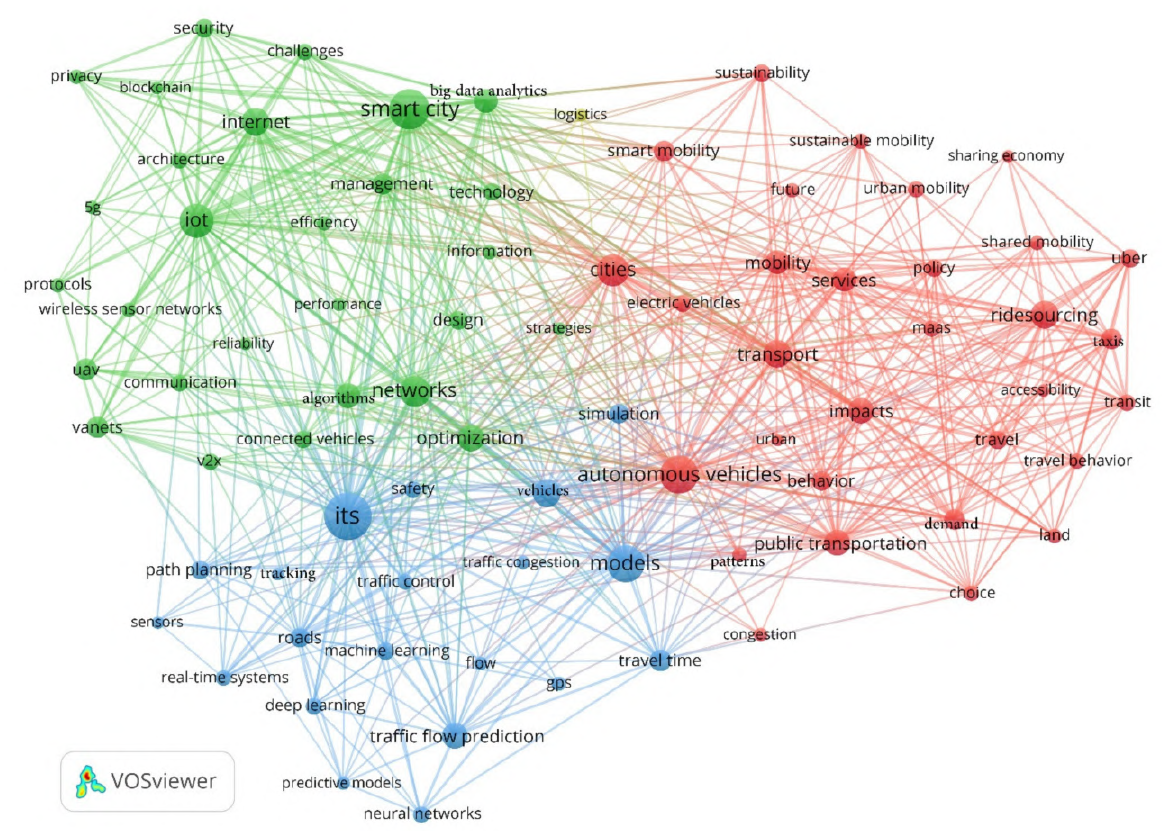
Figure 7. Mapping term co-occurrence from 1968 to 2021. Illustration by